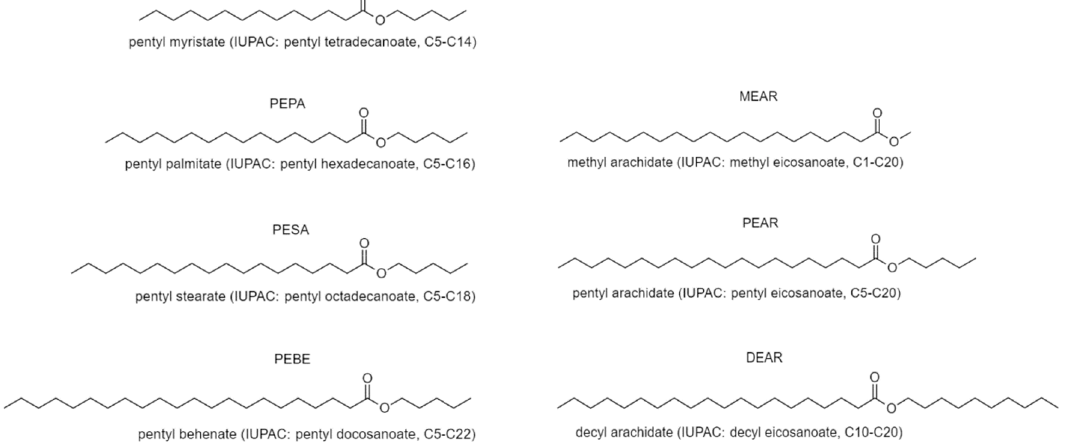
Figure A1. Structures and trivial names of esters produced, with IUPAC nomenclature and carbon length shortening in between brackets. The carbon length shortening indicates first the number of carbons in the alcohol, and subsequently the number of carbons in the carboxylic acid chain. For example, pentyl arachidate derives from 1-pentanol (C 5 ) and arachidic acid (C 20 ), therefore is indicated as C 5 -C 20 .